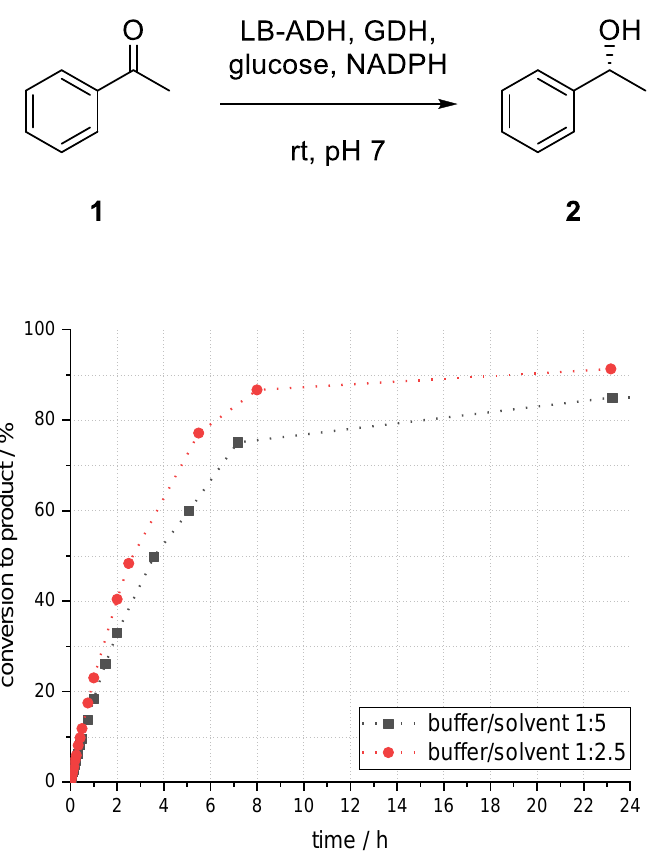
Figure 8. Influence of bu ff er-to-solvent ratio on the conversion to phenylethanol ( R )- 2 in an enzymatic reduction of acetophenone ( 1 ) using ADH in superabsorber-immobilized aqueous phase. 3.5. Studies on the Influence of the Bu ff er Concentration on the Acetophenone Reduction with a Superabsorber-Immobilized Recombinant Alcohol Dehydrogenase from Lactobacillus brevis Also, the influence of potassium phosphate bu ff er (PPB) bu ff er concentration was investigated. Because the superabsorber itself acts as a bu ff er system and because stoichiometric amounts of acid were formed due to the GDH-based cofactor regeneration system, this system was di ffi cult to quantify. By increasing the PPB bu ff er concentration from 100 to 200 mM, the conversion to the desired product after 24 h increased from 85% to 94% (Figure 9). The results have been confirmed in a second experiment